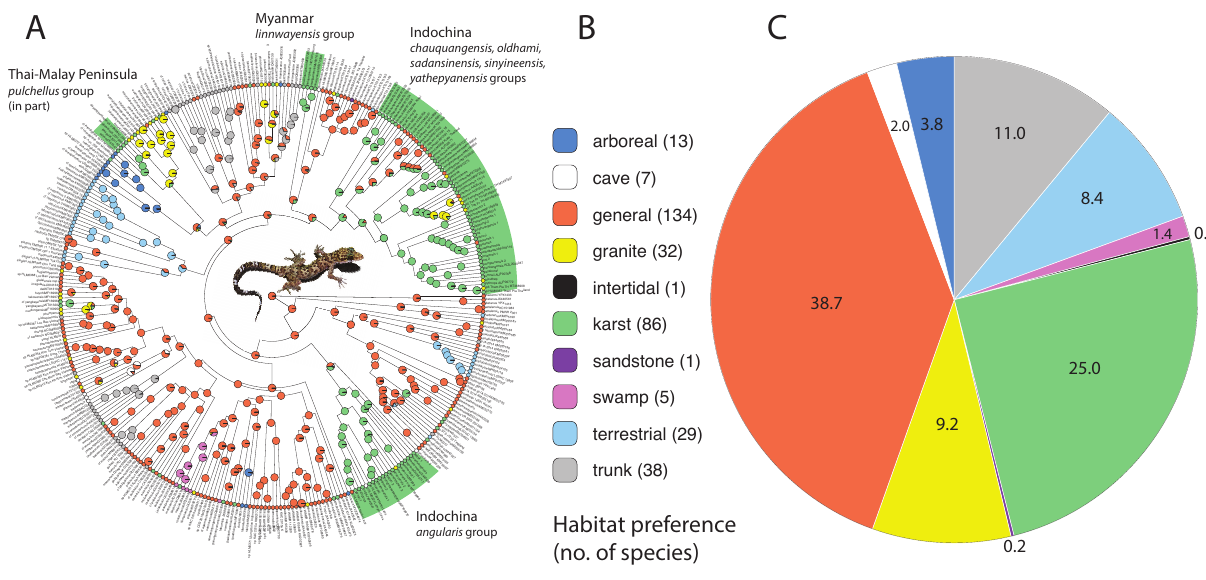
Figure 7. ( A ) Stochastic character map of the 10 habitat preferences on a maximum clade credibility BEAST phylogeny showing the probability of the ancestral habitat preference at each node and the major clades of karst-associated species groups and their general geographic distribution. ( B ) The habitat preference of each species, and the number of species in each habitat preference category. ( C ) Pie chart showing the percentage of species bearing each of the 10 habitat